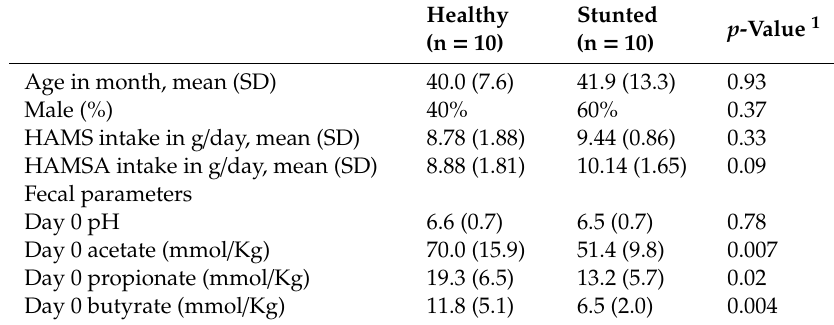
Table 1. Participant characteristics and high amylose maize starch (HAMS) and acetylated HAMS (HAMSA) consumption.